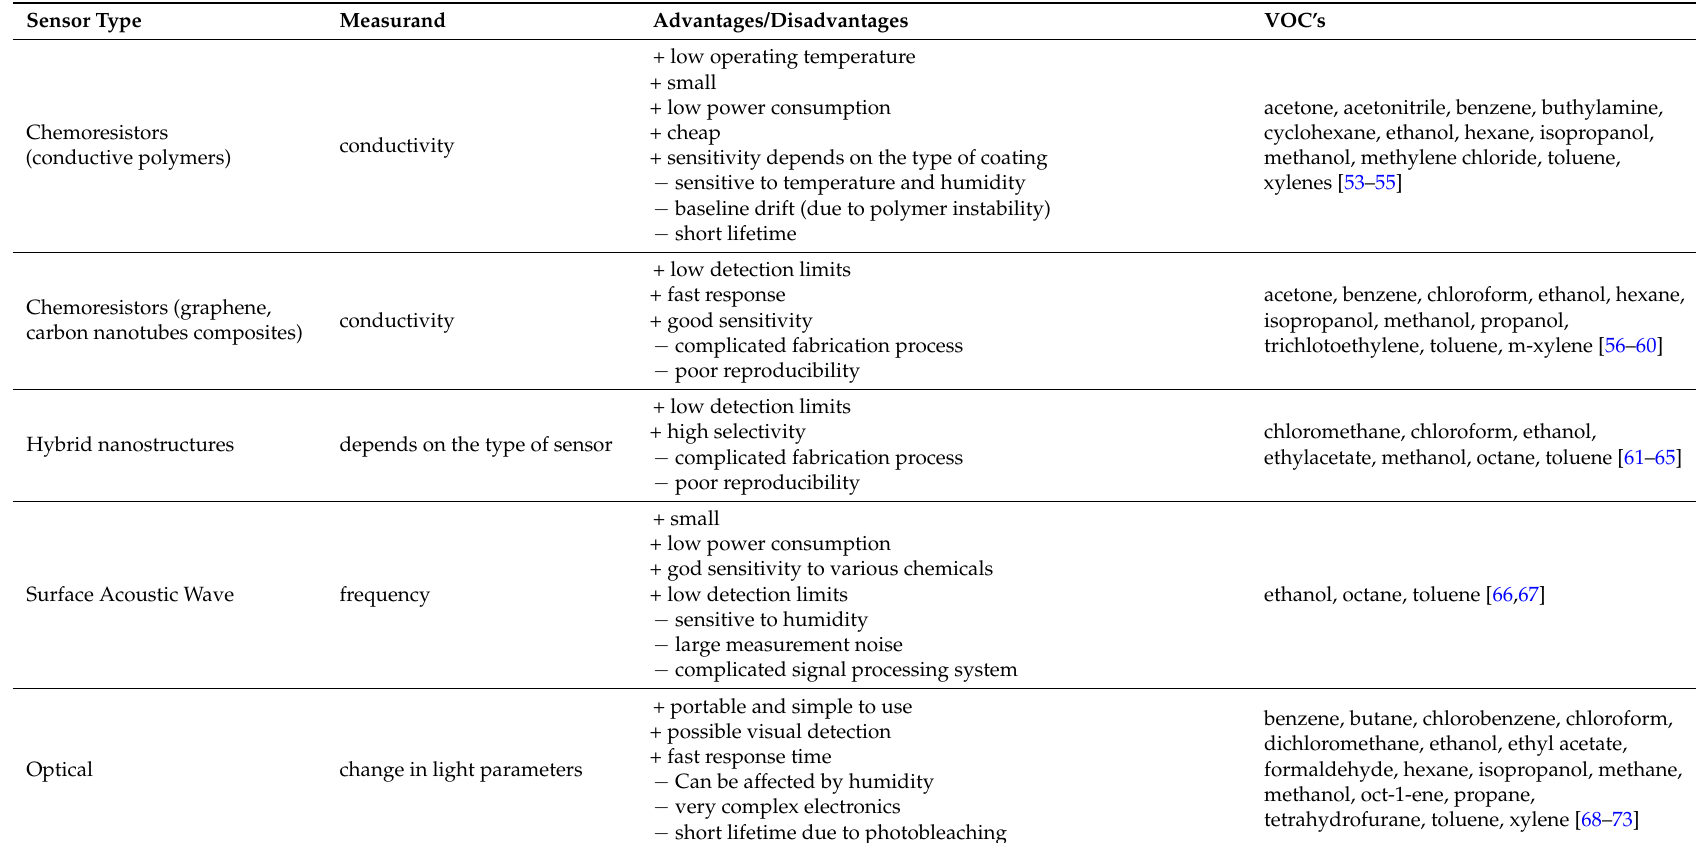
Table 4. Other chemical sensors used to detection